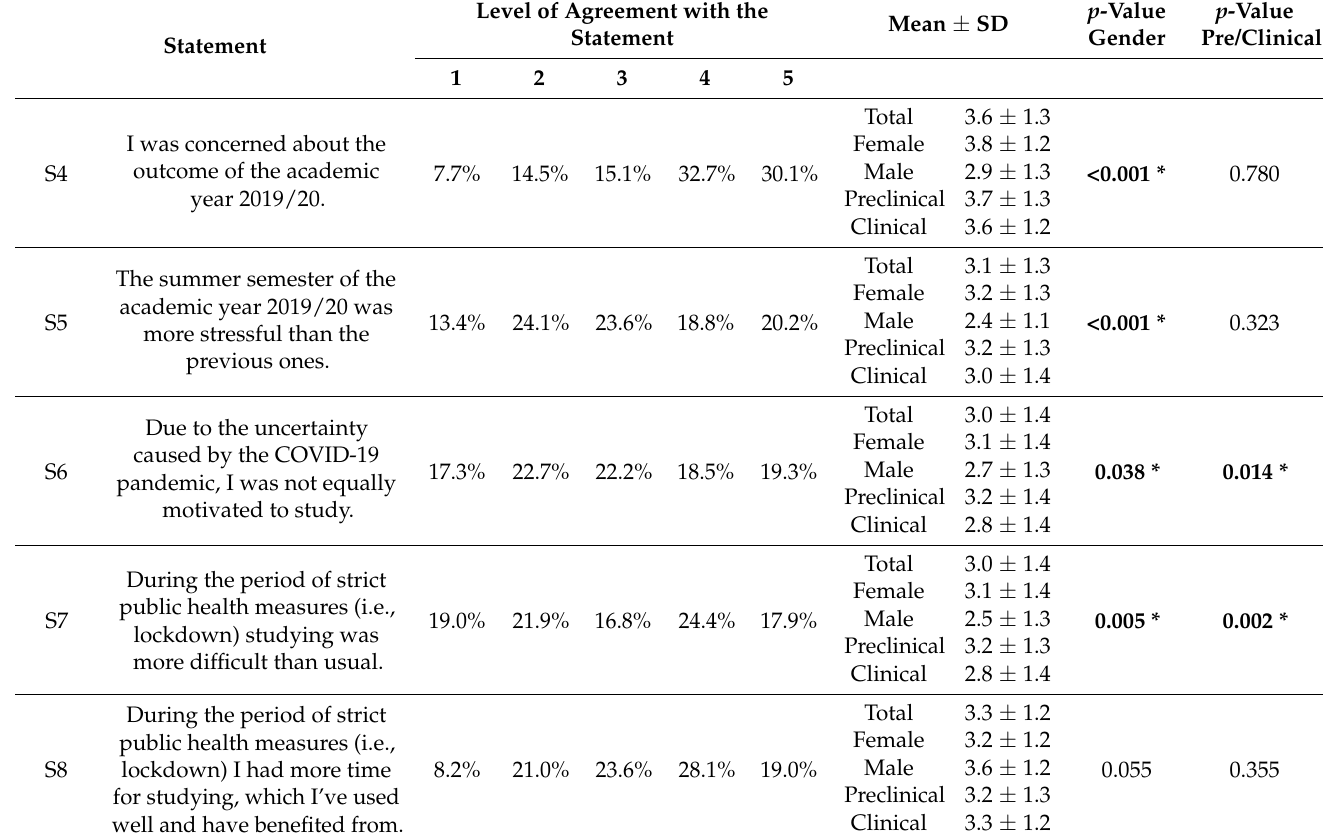
Table 3. The self-perceived educational impact of the COVID-19